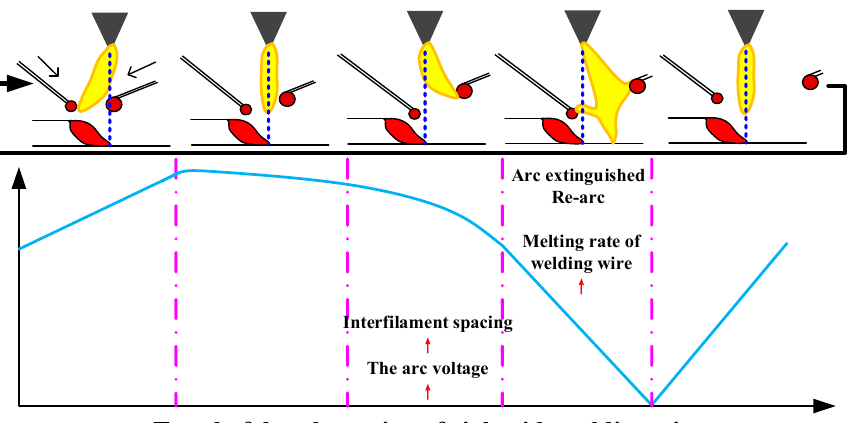
Figure 3. Periodic extinguishment and ignition of AC arc in the mode of “free transfer + free trans- fer.”